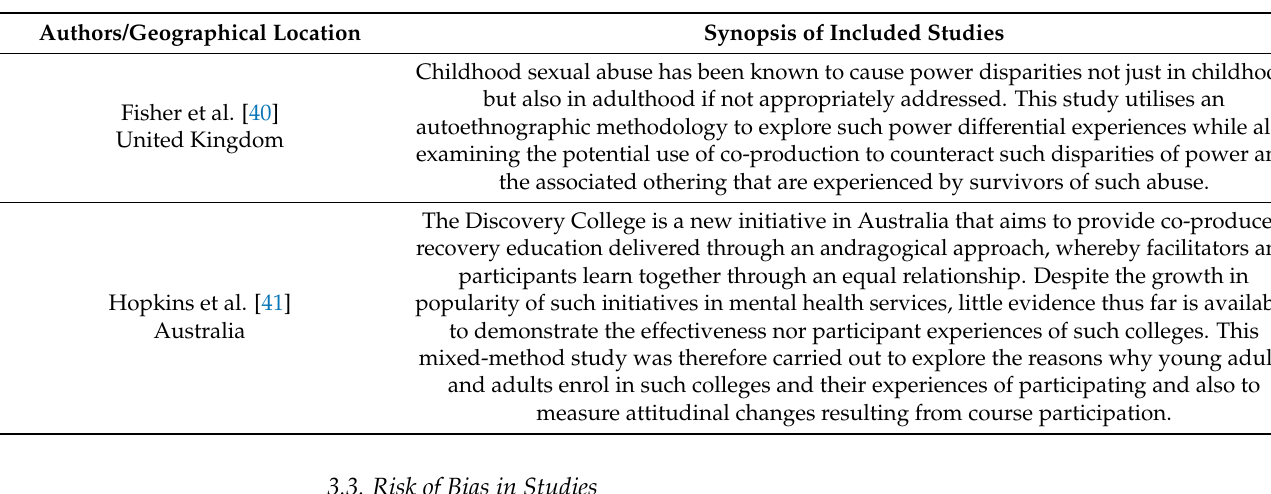
Table 3. Qualitative synopsis of included studies.